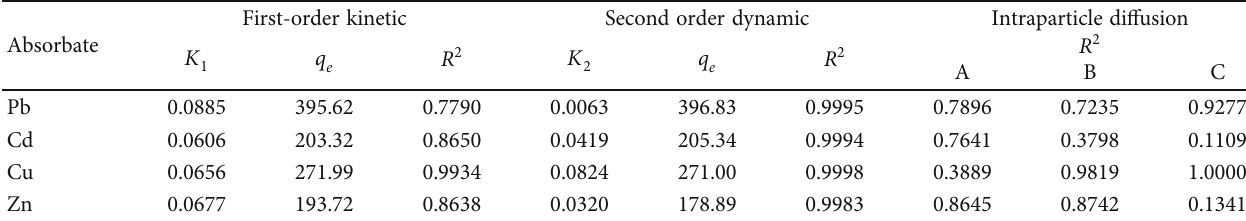
Table 1: Fitting parameters of adsorption kinetics of heavy metals by